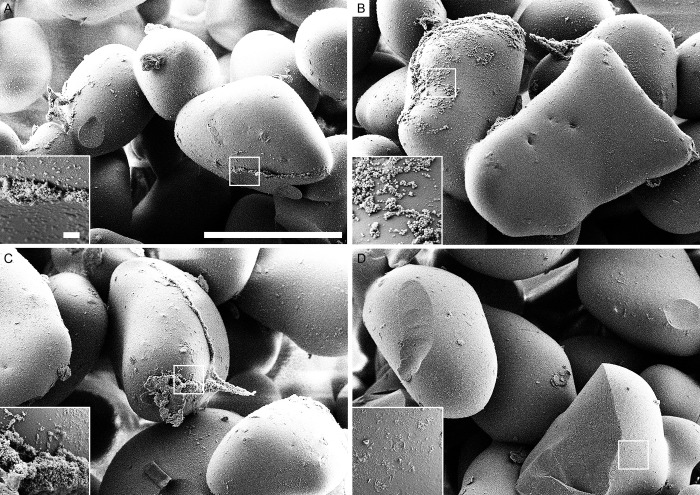
Scanning electron microscopy (SEM) of S. epidermidis biofilm.(A) beads after 0.9% NaCl treatment (control). (B) beads after EDTA treatment. (C) beads after DTT treatment. (D) beads after sonication treatment. Scale bars: 200 μm (inserts in the images represent 5 μm).